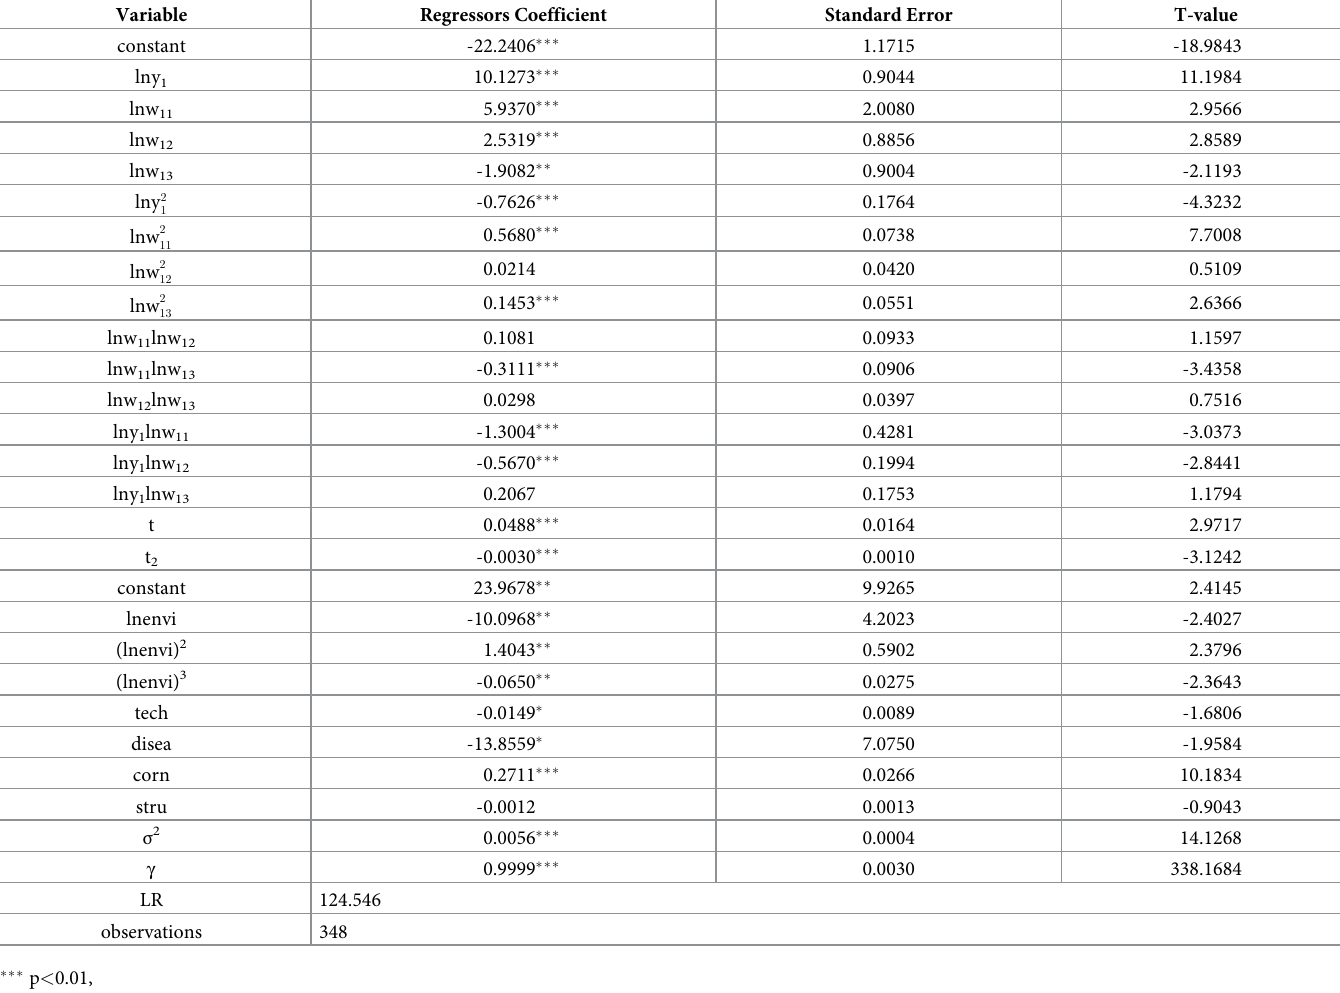
Table 4. Parameters of the translog stochastic cost frontier model for fattening pigs in